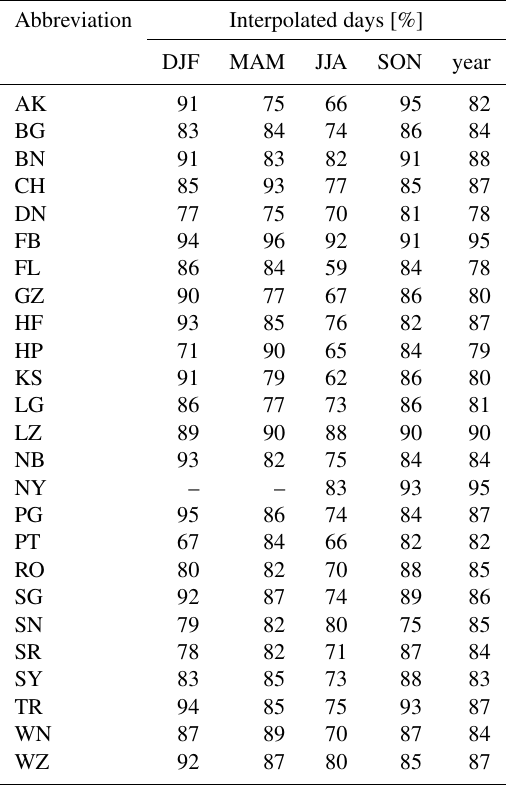
Table D2. As Table 1 but with the relative number of days for each season and the year 2015 to be interpolated for the results of Sect. 4.2.3 for each station (Figs. 7 and 8 Tables 8 and